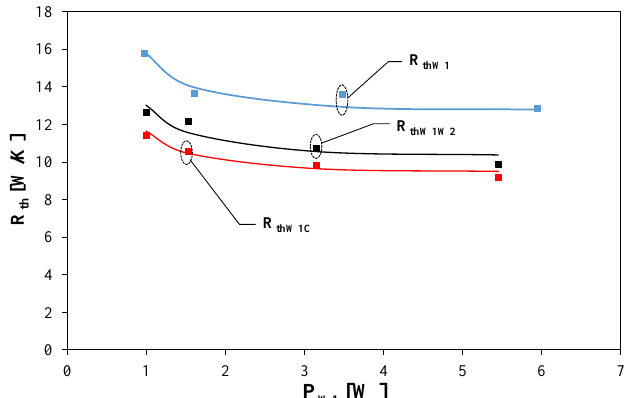
Figure 5. Measured (indicated by points) and modelled (indicated by lines) dependences of the selected thermal resistances in the thermal model of the transformer with a toroidal core made of powdered iron on the power dissipated in the primary winding.